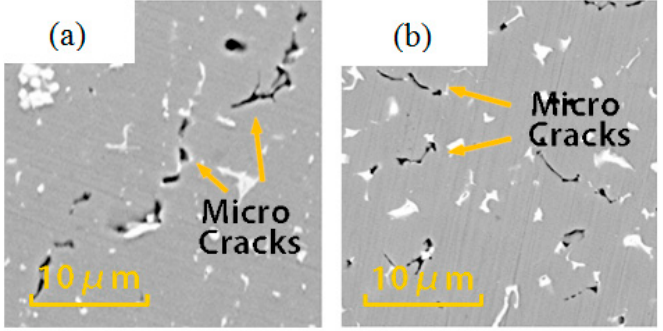
Figure 6. PMZ micro-cracks of ( a ) Alloy 3 and ( b ) Alloy 4.